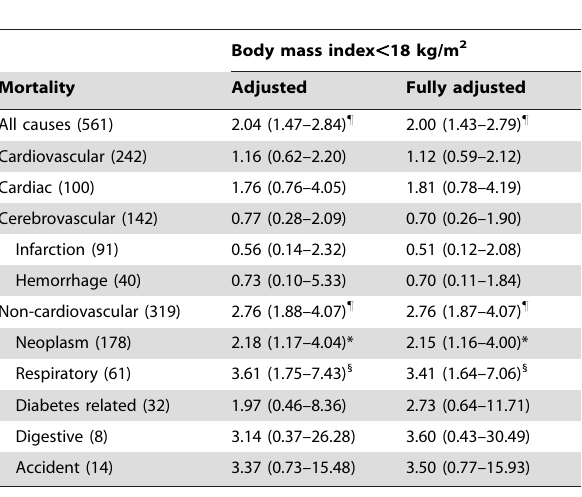
Table 2. Hazard ratios for cause-specific mortality according joint categories of body mass index.